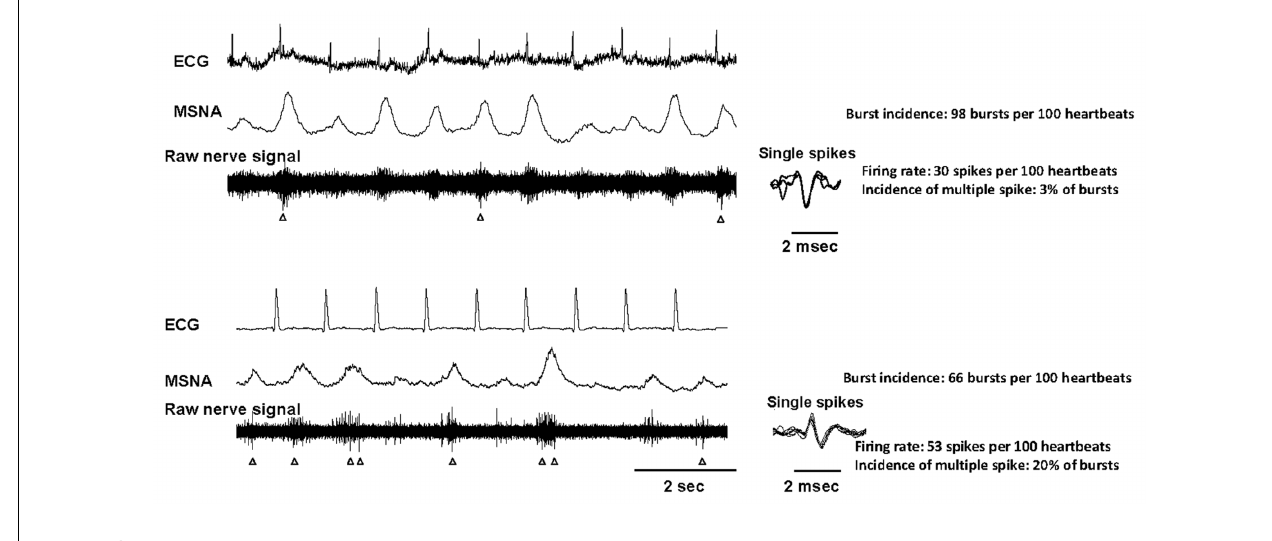
3%.The activity of single vasoconstrictor neurons in the second patient is highly irregular with a firing rate of 53 spikes per 100 heartbeats and the incidence of multiple spikes per bursts of 20%.The spikes are identified by arrows. For each neuron, the superimposition of the spikes (right panels) indicates that the spikes originate from one single vasoconstrictor